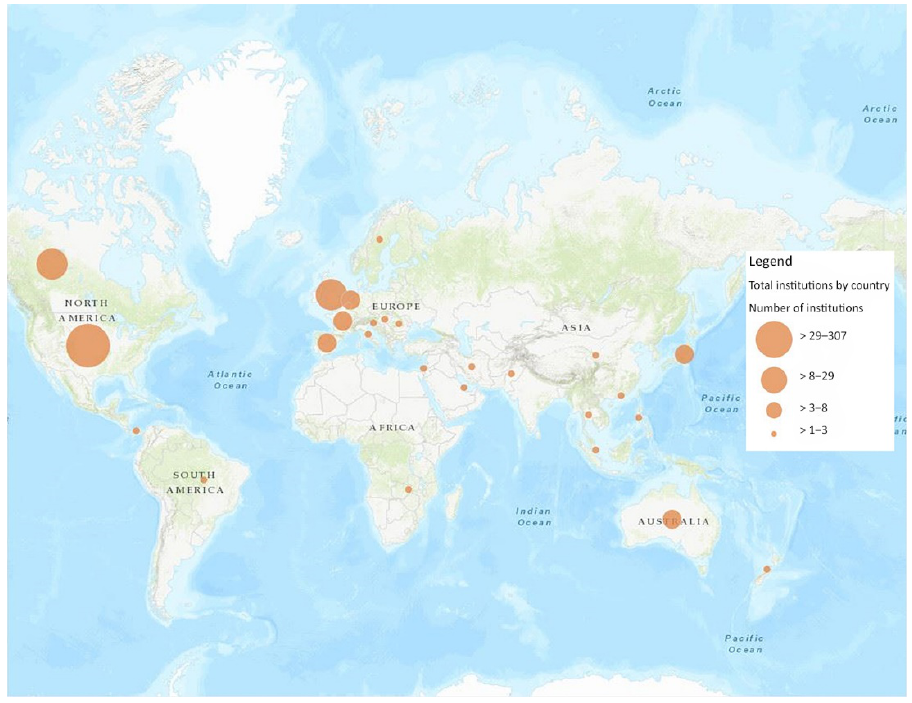
Figure 4 Global distribution of JMLA authorship showing geographic locations of institutions that had at least one JMLA author from 2006–2017